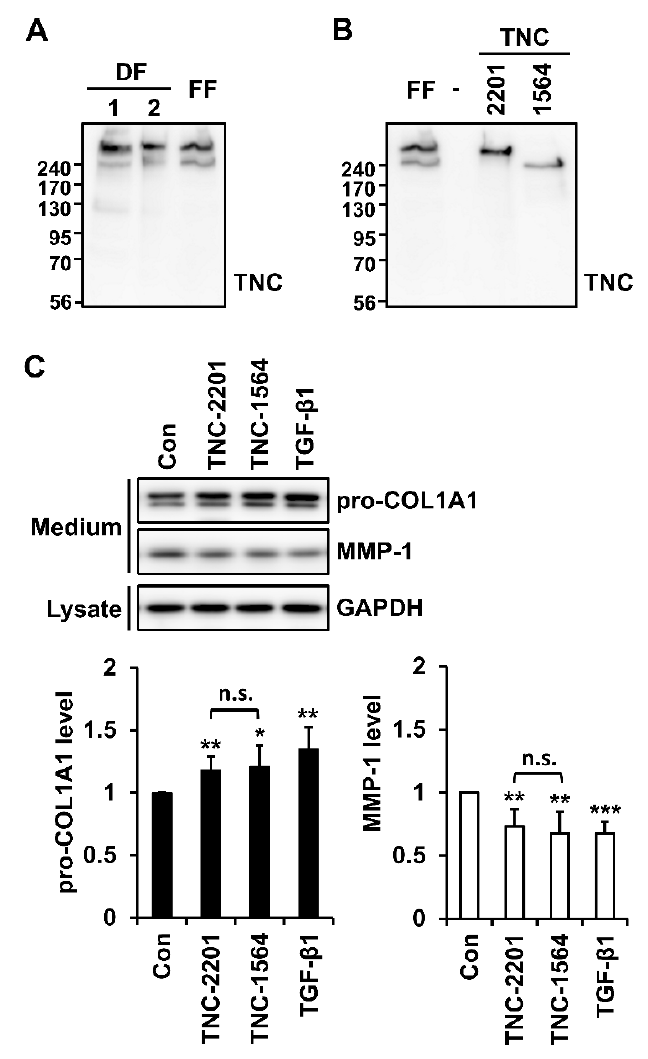
Figure 2. Detection of expression of TNC isoforms in fibroblasts, ectopic expression of recombinant TNC isoforms, and their effects on the secretion of type I collagen and matrix metalloproteinase-1 (MMP-1) in fibroblasts. ( A ) TNC levels were analyzed in conditioned media from two independent lines of human dermal fibroblasts (DF) and one foreskin fibroblast (FF) line by western blotting with an antibody against TNC. ( B ) Constructs expressing the large (TNC-2201) and small (TNC-1564) TNC isoforms were transfected into COS-1 cells, and the purified TNC proteins were analyzed by western blotting with TNC antibody. -: vector control. ( C ) Human foreskin fibroblasts were incubated with serum-free Dulbecco’s modified Eagle’s medium (DMEM) in the absence (Con) or presence of TNC (2 µg/mL) or transforming growth factor- β 1 (TGF- β 1) (3 ng/mL) for 24 h. Levels of type I collagen and MMP-1 were evaluated in conditioned media and that of GAPDH in cell lysates by western blot analysis using antibodies against pro-COL1A1, MMP-1, and GAPDH. Graphs show the relative protein levels of pro-COL1A1 and MMP-1. Each value represents the mean ± SD of six independent experiments. * p < 0.05, ** p < 0.01, *** p < 0.001 vs. Con. n.s.: not